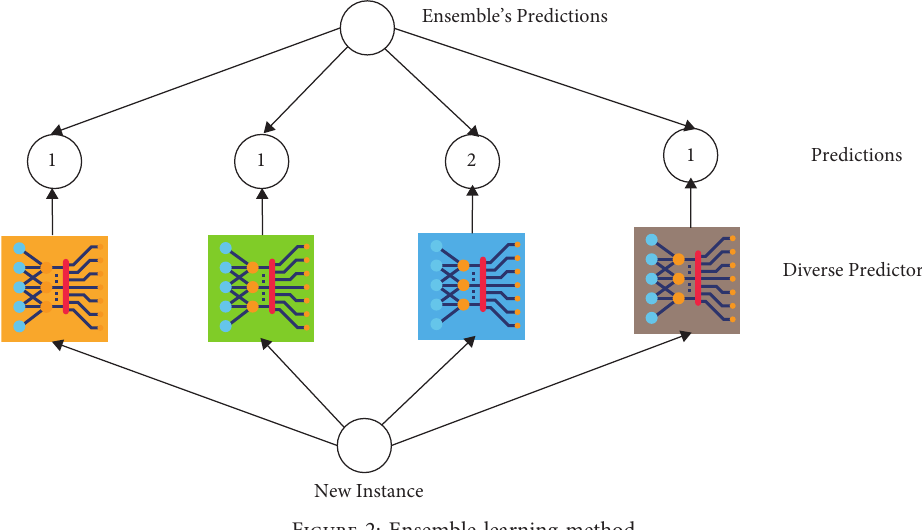
Figure 2: Ensemble learning